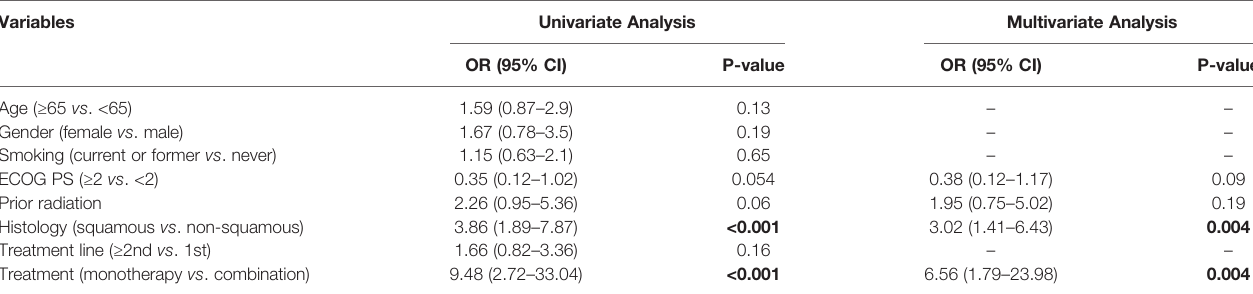
TABLE 2 | Univariate and multivariate logistic regression analysis for the risk factors of CIP.